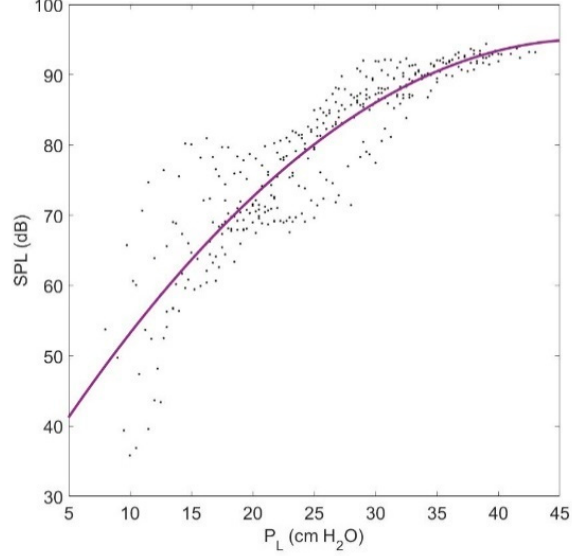
Figure 7. Scatter plot of SPL vs. P L with a quadratic polynomial fit.